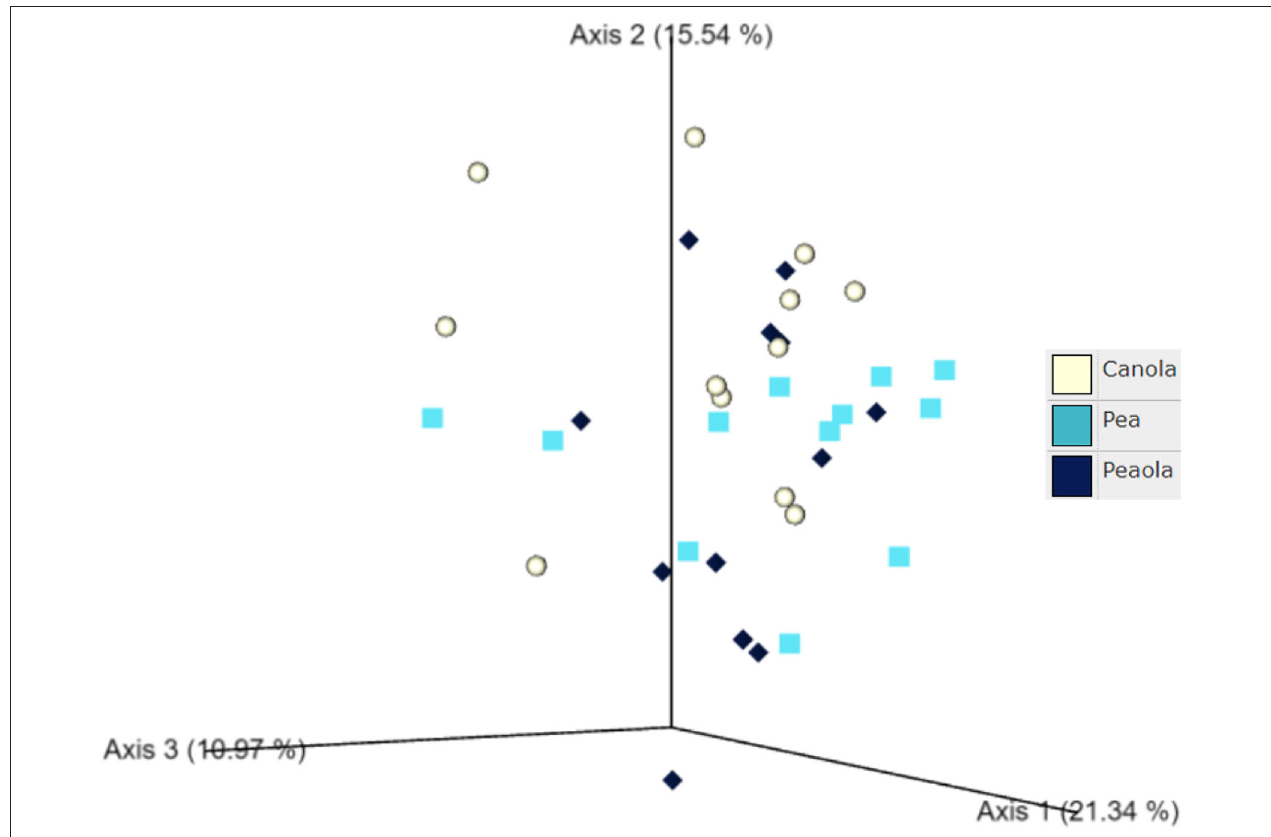
FIGURE 7 | Ordination showing the results of the Weighted UniFrac Distance comparison performed between the different cropping systems. A trend was found toward there being a difference in the community composition of the pea and canola monoculture soils (PERMANOVA, F = 2.06, P = 0.0705) and the peaola and canola monoculture soils (PERMANOVA, F = 1.72, P = 0.0705). No significant difference or trend was found between the pea monoculture and peaola soils (PERMANOVA, F = 1.06, P =